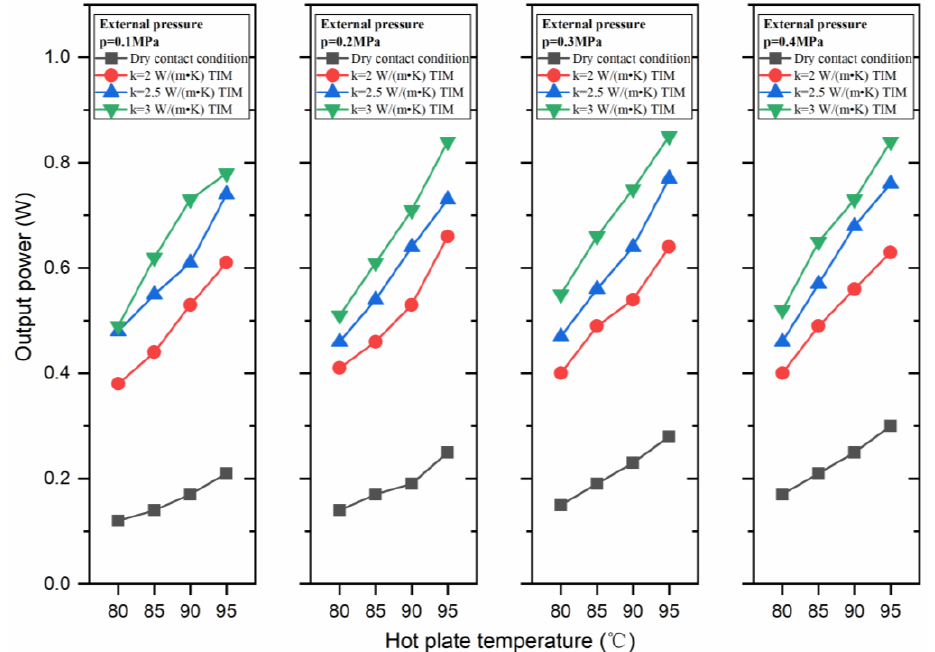
Figure 7. Effect of using thermal greases with different thermal conductivities as thermal interface Figure 7. E ff ect of using thermal greases with di ff erent thermal conductivities as thermal interface material on output power of TEG module. material on output power of TEG